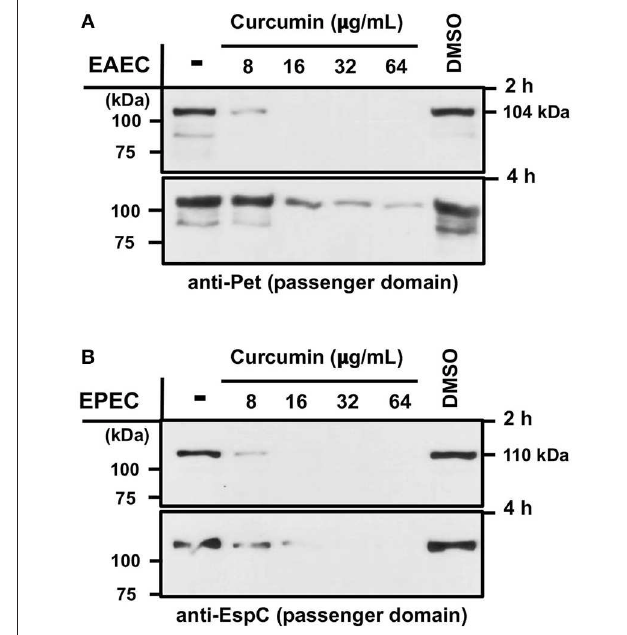
FIGURE 2 | Curcumin inhibits the secretion of SPATEs Pet and EspC (from EAEC and EPEC, respectively) in a concentration- and time-dependent manner. Bacterial cultures of EAEC 042 and EPEC E2348/69 were grown using different curcumin concentrations of (8, 16, 32, 64 µ g/mL) for 2 and 4h at 37 ◦ C at 150 rpm. Bacteria were pelleted and the culture supernatants were precipitated for proteins collection (see section Materials and Methods). Protein bands were analyzed by Western-blot using a specific antibody for Pet (A) and EspC (B) passenger domains, followed by HRP-conjugated goat anti-rabbit IgG secondary antibody. As controls, bacterial strains without curcumin or with vehicle (DMSO) were